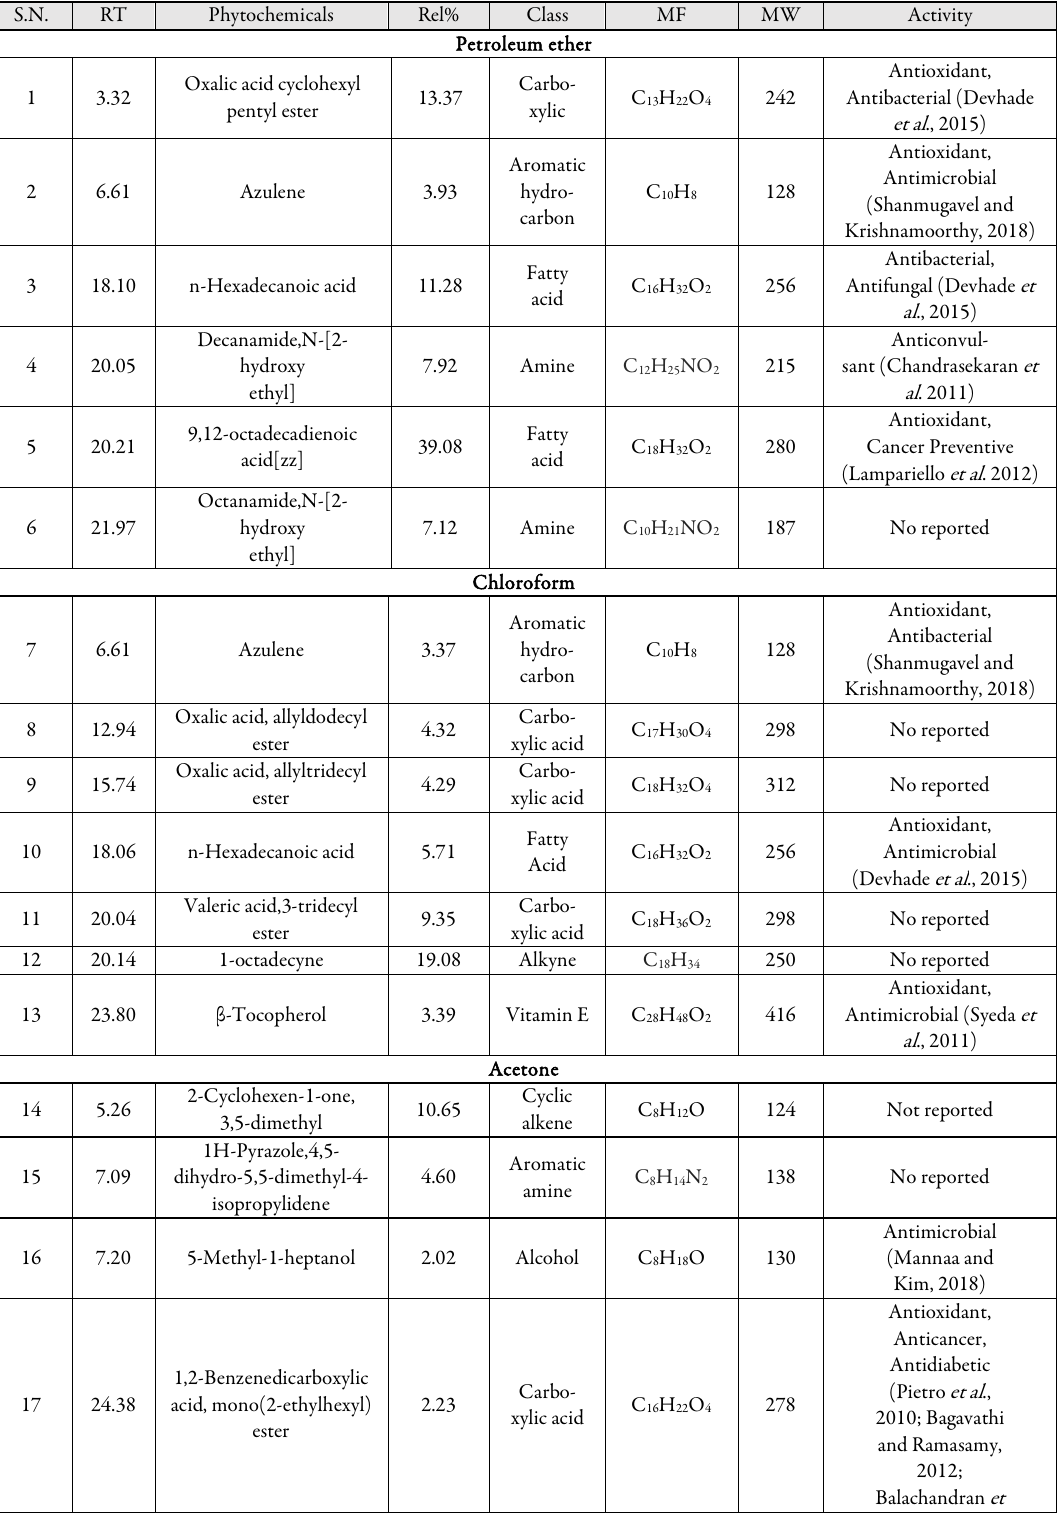
Table 4. Bioactive compounds identified in different solvent extract of Mucuna pruriens (L.). DC. Seeds